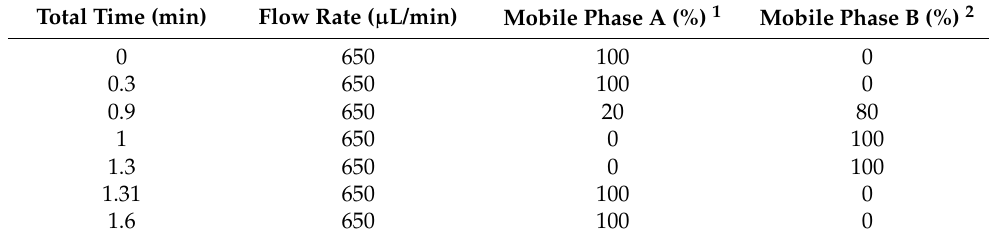
Table 1. Elution gradient used for C18 column for active substances quantification. Total Time (min) Flow Rate ( µ L/min) Mobile Phase A (%) 1 Mobile Phase B (%) 2